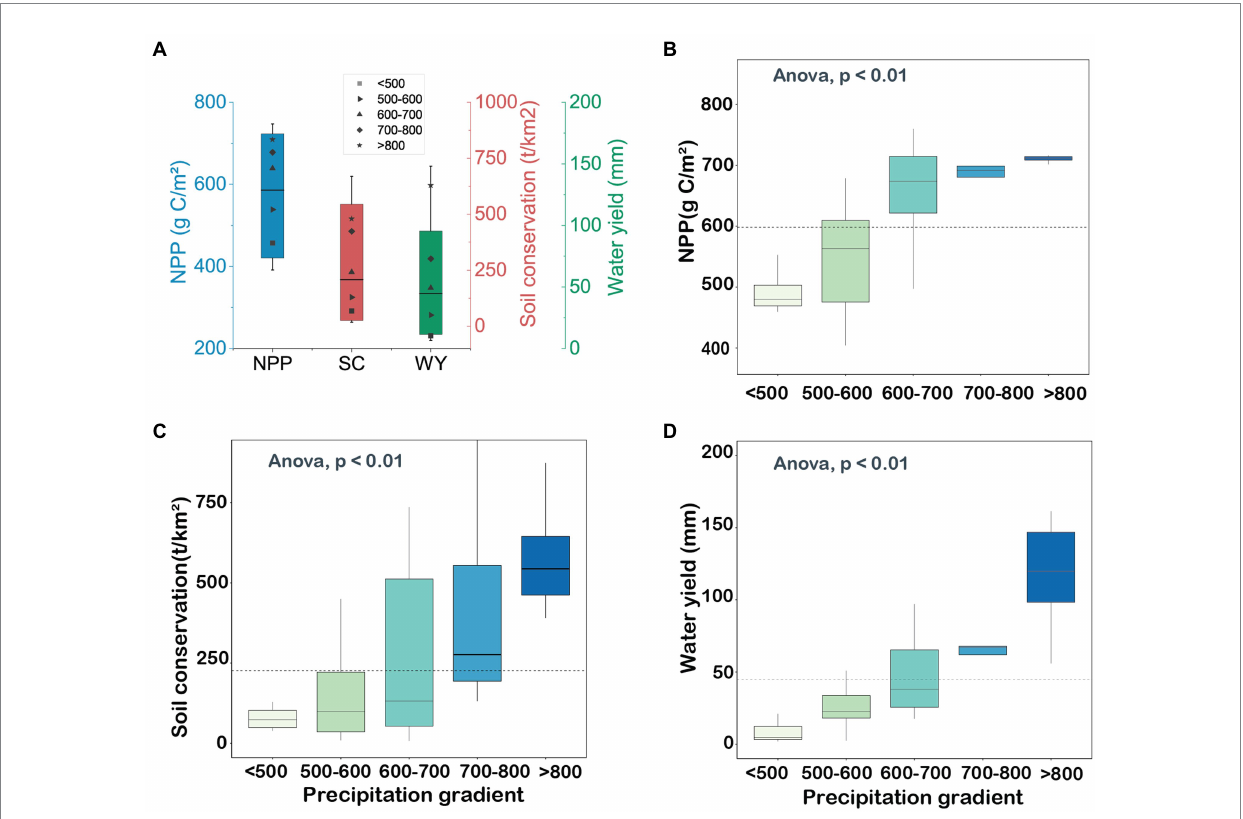
FIGURE 3 Three ESs in the forest natural reserves and the average of ESs under each precipitation gradient (A) ; Variation of ESs along the precipitation gradients ( B: NPP; C: Soil conservation; D: Water